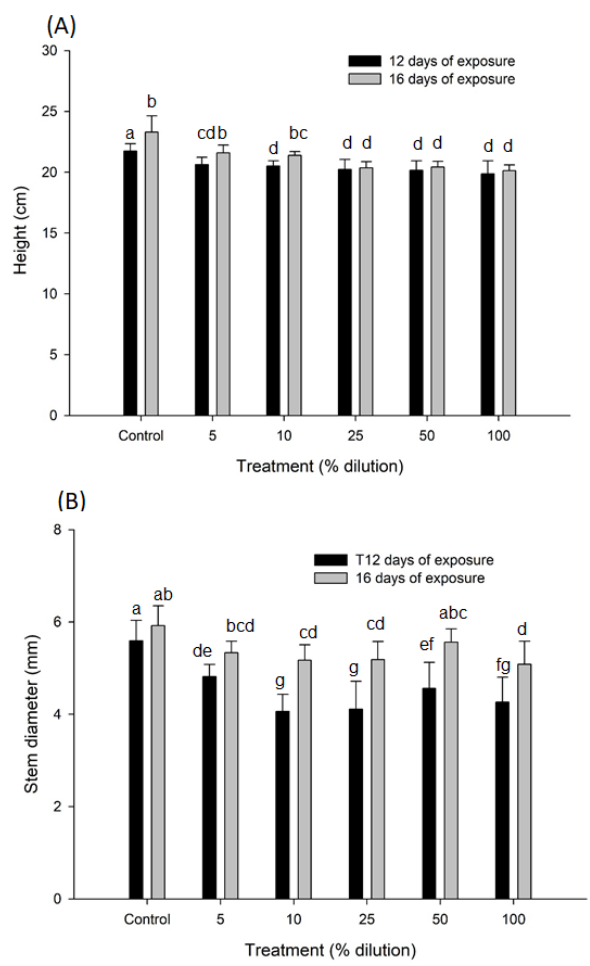
Figure 4. Average growth in (A) height; (B) stem diameter of Rhizophora mangle seedlings between treatments and exposure times. The error bars represent the standard deviation. Treatments that do not share a letter are significantly different (p ≤ 0.05).